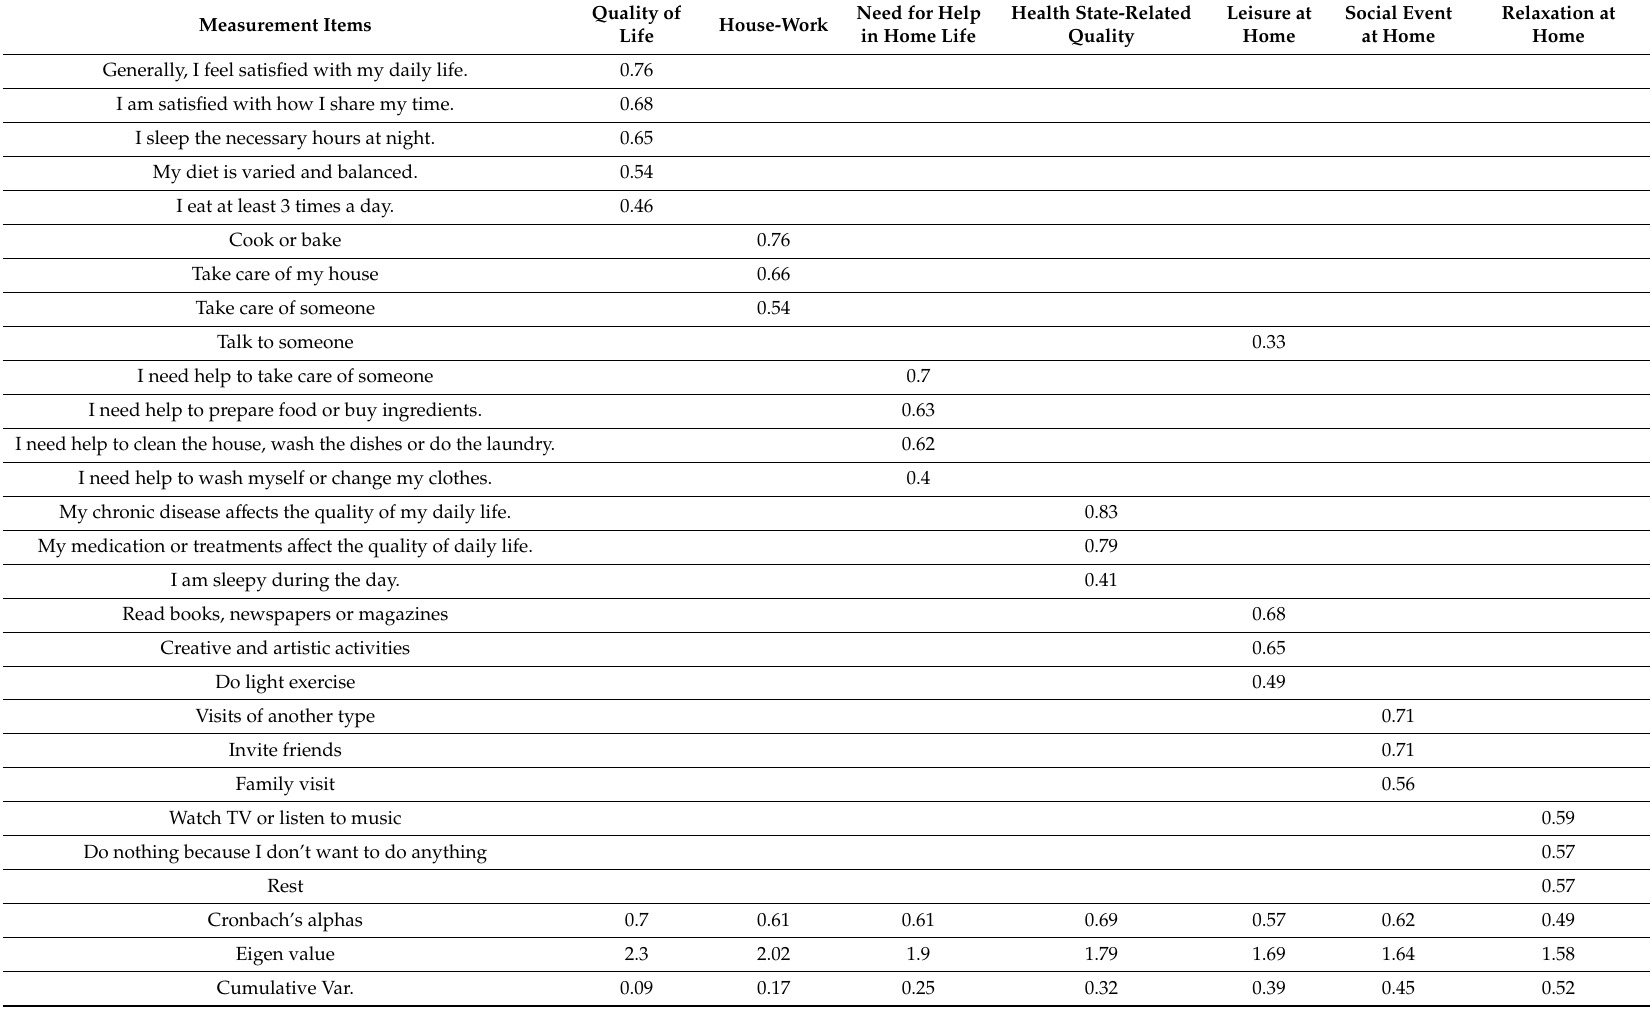
Table 1. Factor analysis of residentially-based